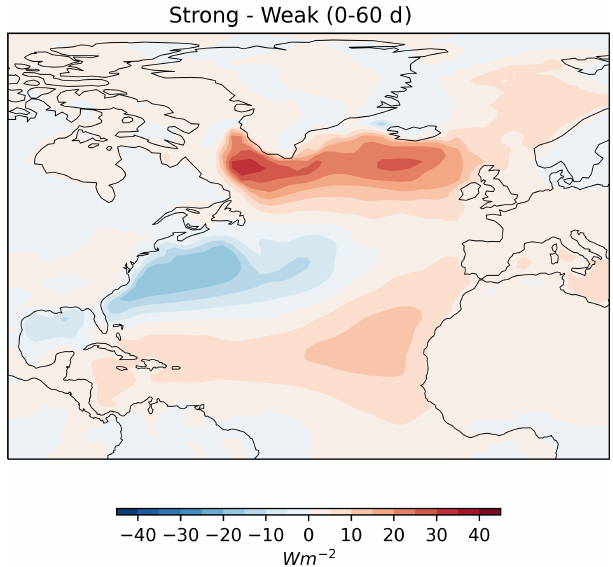
Figure 6. Surface ocean–atmosphere heat flux pattern associated with anomalous winter stratospheric NAM 10 events averaged be- tween 0–60d, following vortex events. Coloured shading shows the composite differences between strong and weak NAM 10